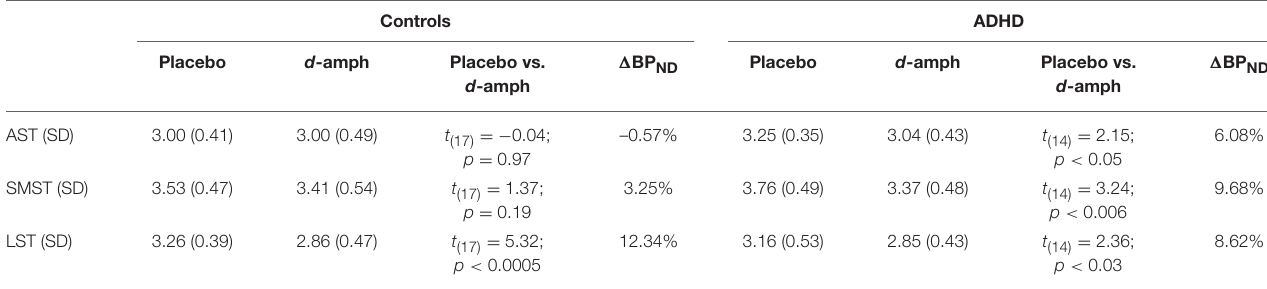
TABLE 2 | D2/3 binding potential (BP ND ) and 1 BP ND in striatal ROIs.